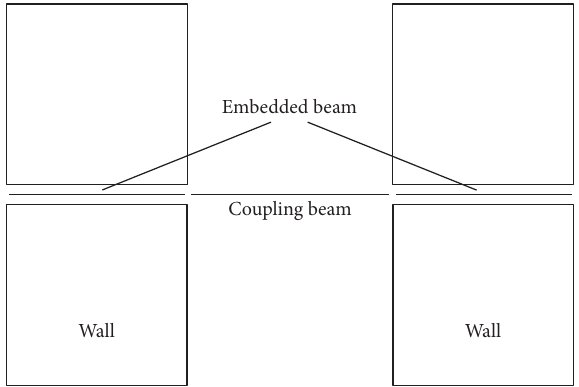
Figure 10: Connection between wall and coupling beam in